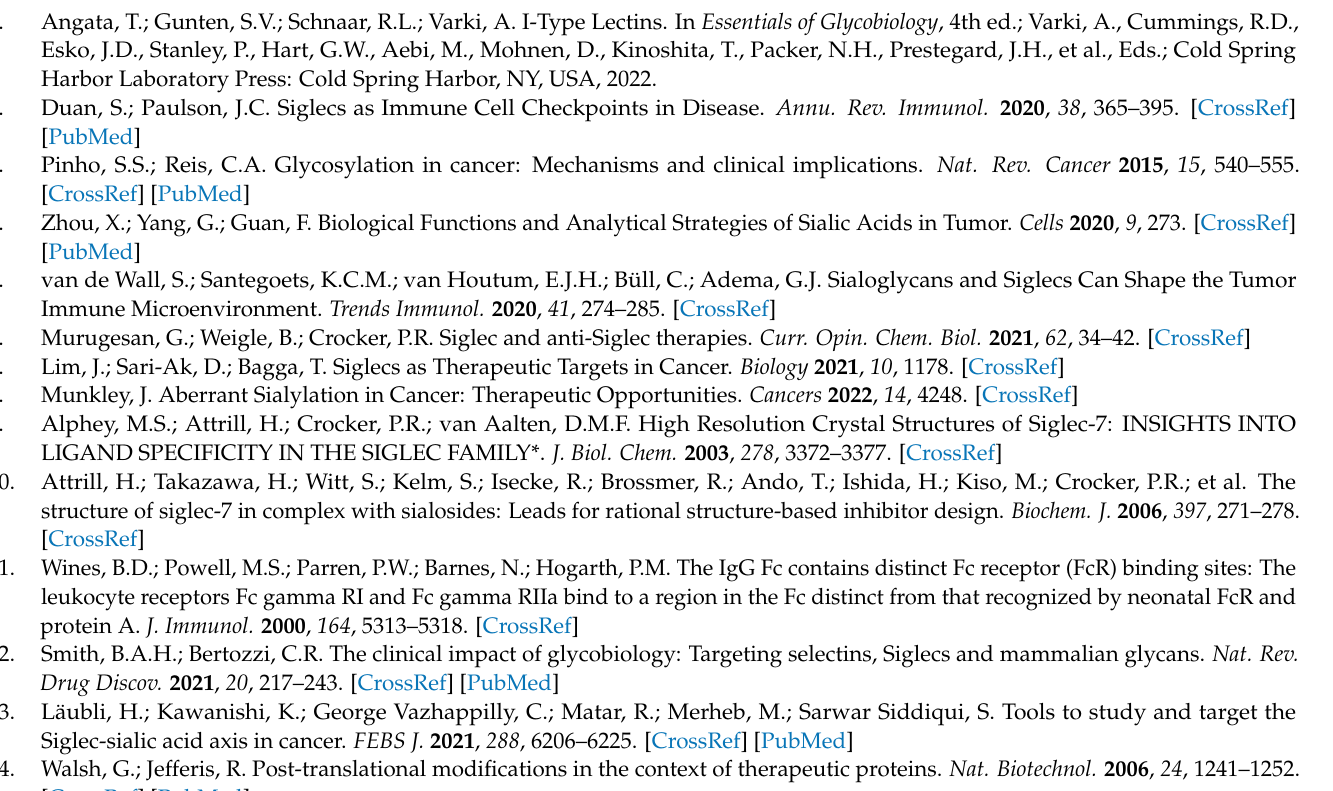
Identified IP experiment proteins’ correlation coefficient using Siglec9-Fc producing in HEK293 or CHO; Figure S5: Siglec9-Fc ligands on T24 bladder cancer cell; Figure S6: Raw data of western blot and dot blot graphs; Figure S7: Flow cytometry analysis of Siglec9-Fc binding on cell surface, raw data of Figure 5a; Figure S8: Flow cytometry analysis of Siglec9-Fc binding on cell surface, raw data of Figures 2d and 5a; Table S1: HEK293-Siglec9-Fc glycopeptides MS/MS result;